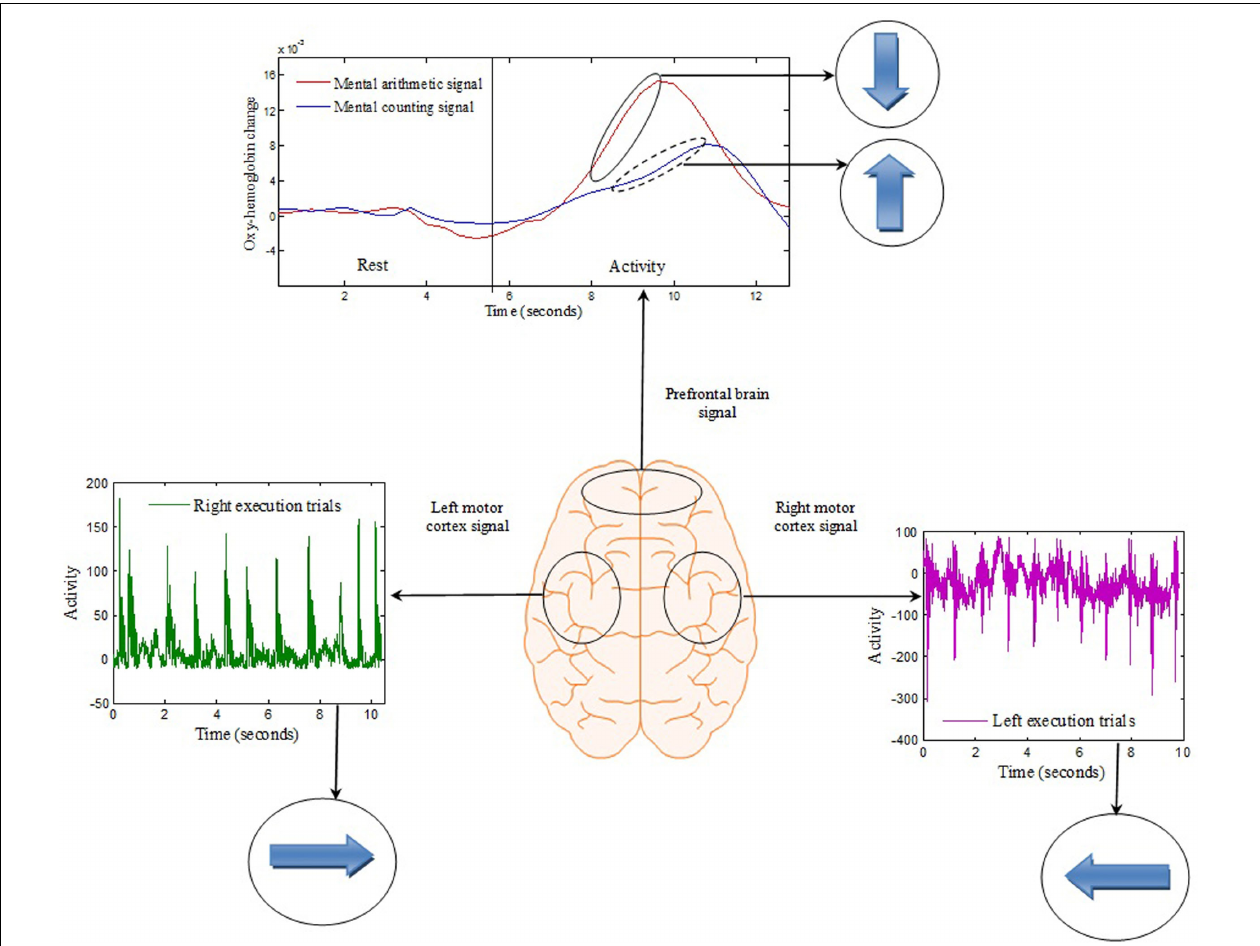
FIGURE 4 | Brain-signal acquisition: Each spike from the left or right motor cortex represents a hand tapping with the right or left hand, respectively. The concentration change in the prefrontal brain region reflects the change from rest to mental counting (“forward”) and mental subtraction (“backward”).